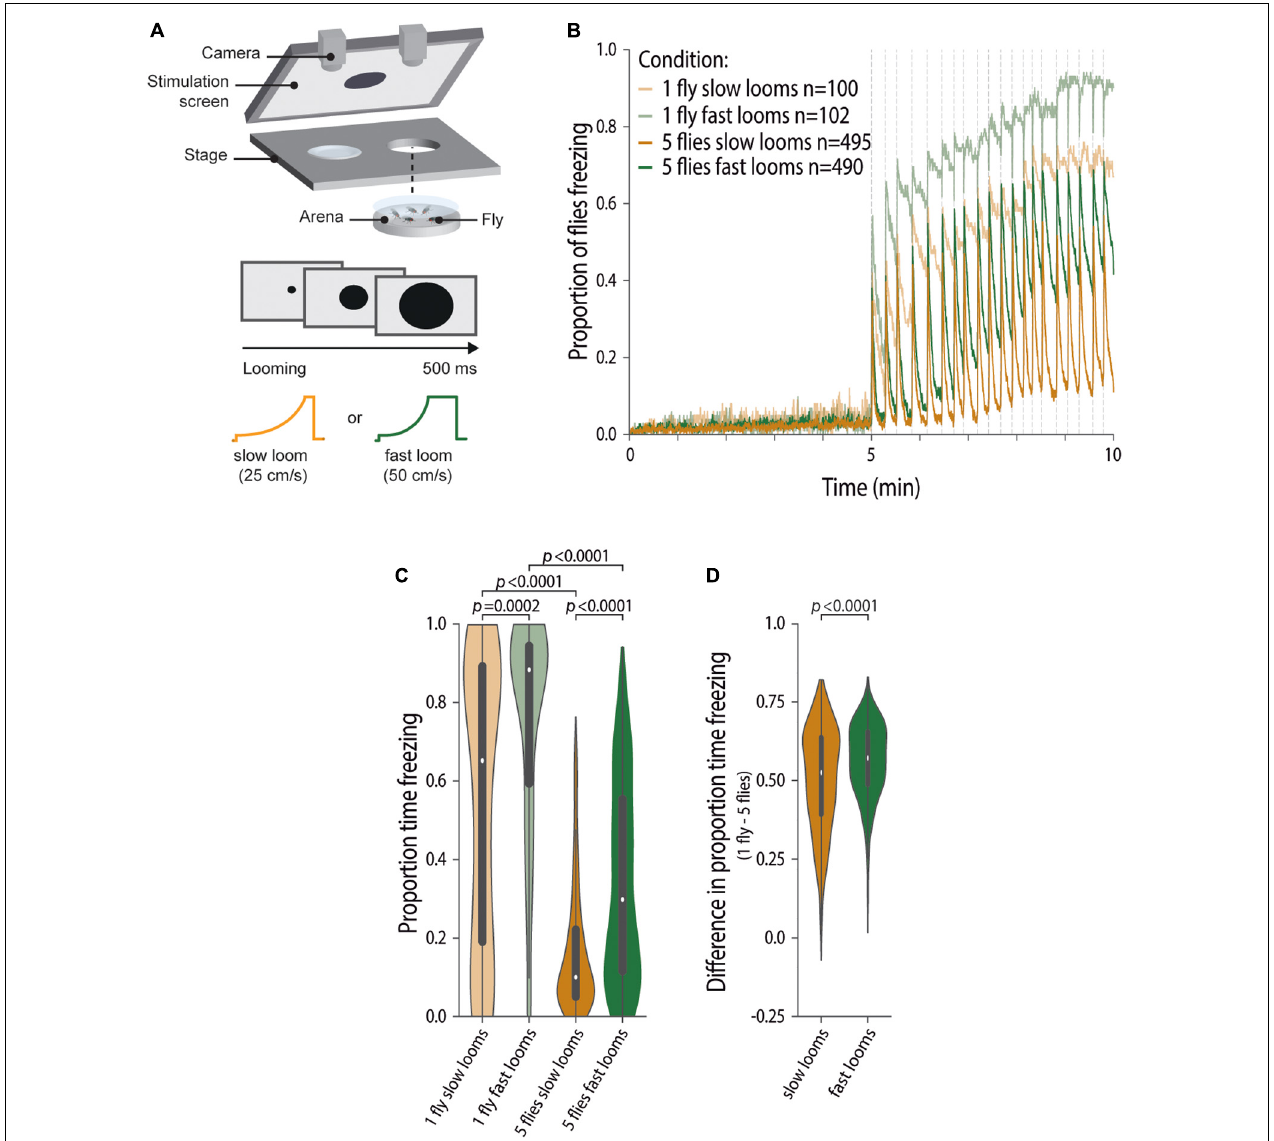
FIGURE 1 | Group freezing responses scale with threat imminence. (A) Experimental setup and conditions: we tested individuals and groups of five flies in backlit arenas imaged from above; after a 5-min baseline, flies were exposed to twenty 500 ms looming presentations, every 10–20 s; we provided either slow (25 cm/s, purple) or fast looms (50 cm/s, green). (B,C) Data for flies tested individually (lighter shades) and in groups (darker shades). (B) Fraction of flies freezing throughout the experiment; dashed lines represent looming stimuli presentations; n represents the numbers of flies tested for each condition. (C,D) Violin plots representing the probability density distribution of individual fly data bound to the range of possible values, with boxplots elements: [central white dot, median; box limits, upper (75) and lower (25) quartiles; whiskers, 1.5 × interquartile range]. (C) Proportion of time spent freezing in the stimulation period. P -values result from Kruskal–Wallis statistical analysis followed by Dunn’s multiple comparisons test. (D) Difference in the proportion of time spent freezing between individually tested flies and flies tested in groups for slow and fast looms (refer to the section “Materials and Methods”). P -value results from the two-tailed Mann–Whitney test.